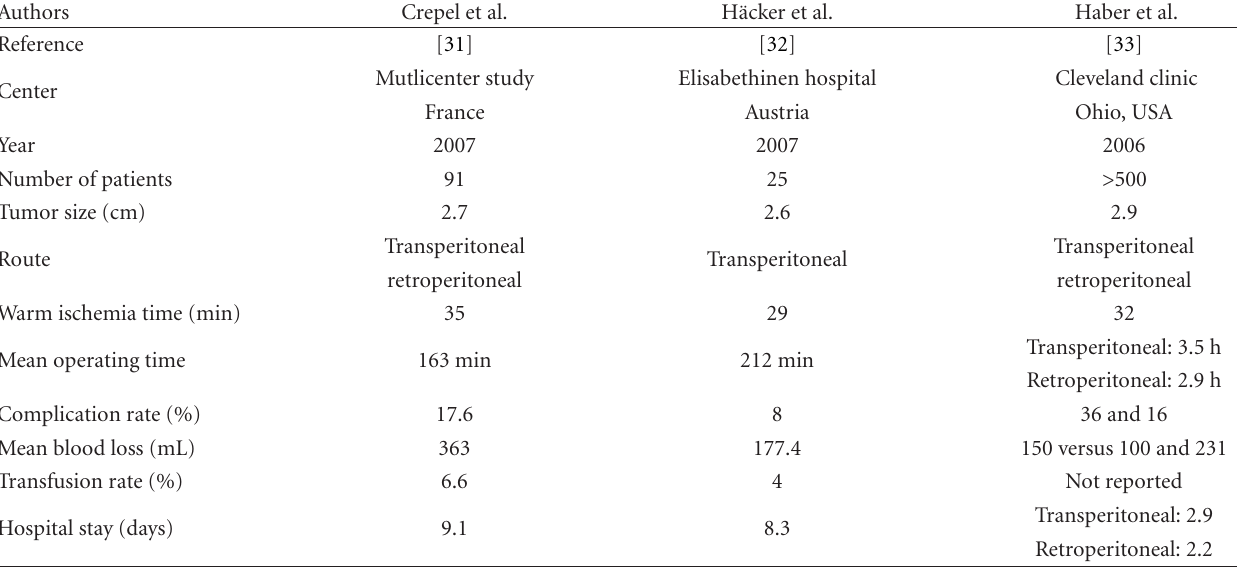
Table 5: Comparison of selected published series related with LPN. Min: